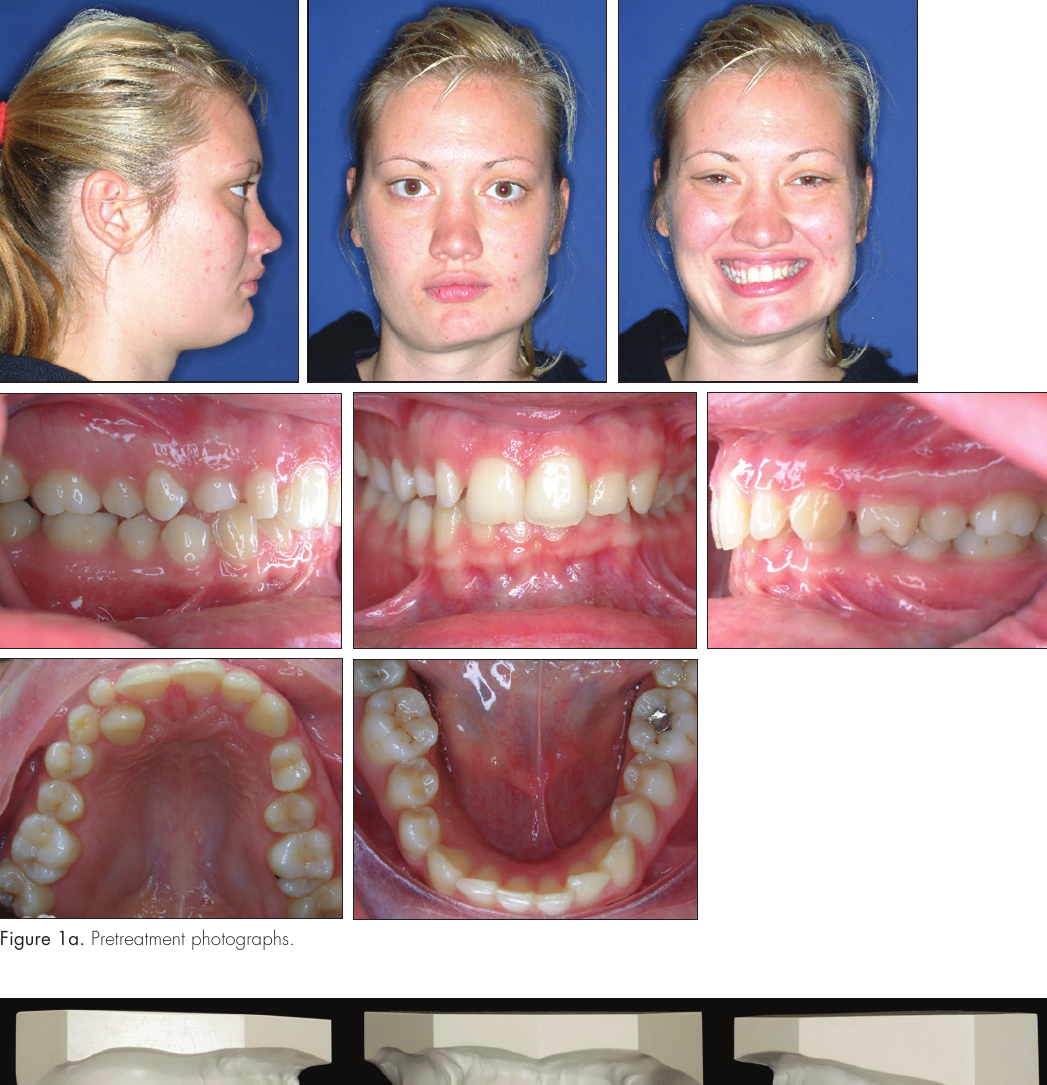
Figure 1a. Pretreatment photographs.